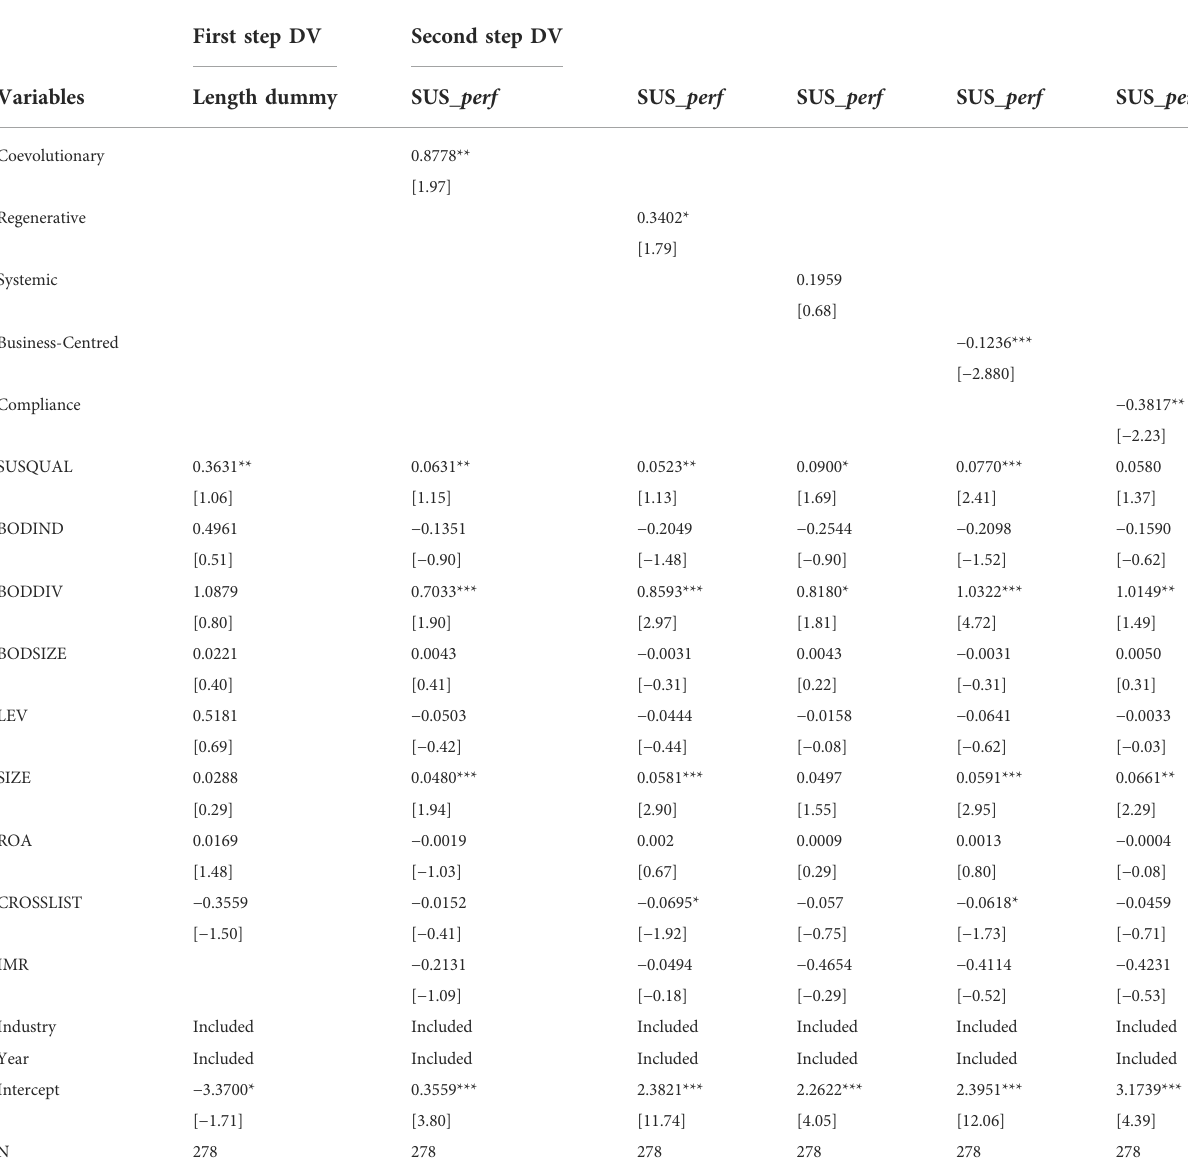
TABLE 7 Heckman (1979) two-step